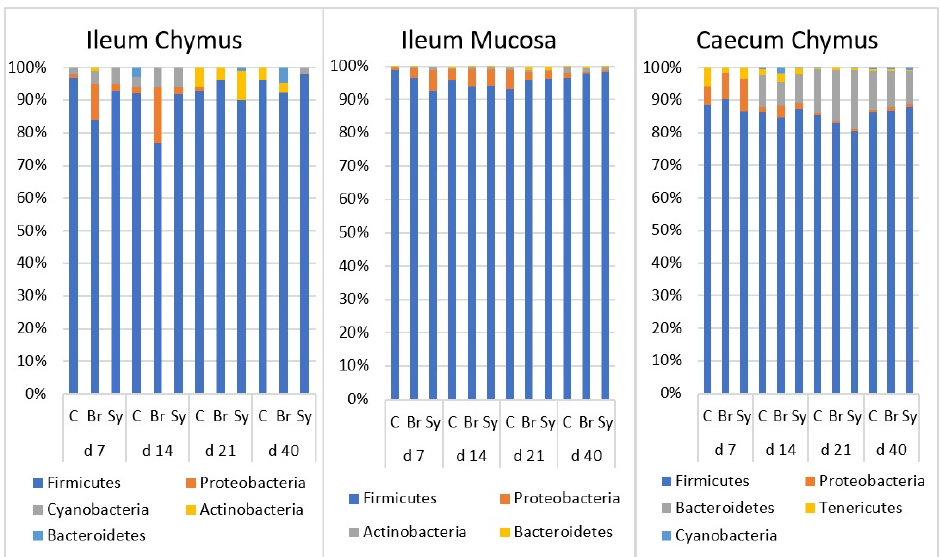
Figure 3. The relative abundance of microbiota at phylum level in the ileal chymus (IC), ileal mucosa (IM), and caecal chymus (CC) as affected by the age of chickens and dietary treatments (C—Control, Br—Broilact ® , Sy—Synbiotic feed additive). Microbial composition at different taxonomical levels and in different intestinal samples (IC, IM and CC) were compared using two-way ANOVA test with Tukey’s HSD multiple group comparison’s post hoc test, using the dietary treatments (C, Br and Sy) and the age of birds (7, 14, 21, and 40 day) as main factors. The differences were considered significant at a level of p ≤ 0.05. Proteobacteria was one of the minor phyla in all three gut areas with a decreasing relative abundance over time. In IC and IM, its relative abundance was significantly higher at d 14 ( p < 0.05) and dropped below 1% later on in IC. Its decrease was slower in the IM and decreased below 1% only at d 40. In CC, the relative abundance was signifi- cantly higher at d 7 ( p < 0.0001) and decreased over time. Bacteroidetes was barely detectable at d 7; its relative abundance increased continu- ously in the caecum until d 21 ( p < 0.0001) and remained at 11% until d 40.